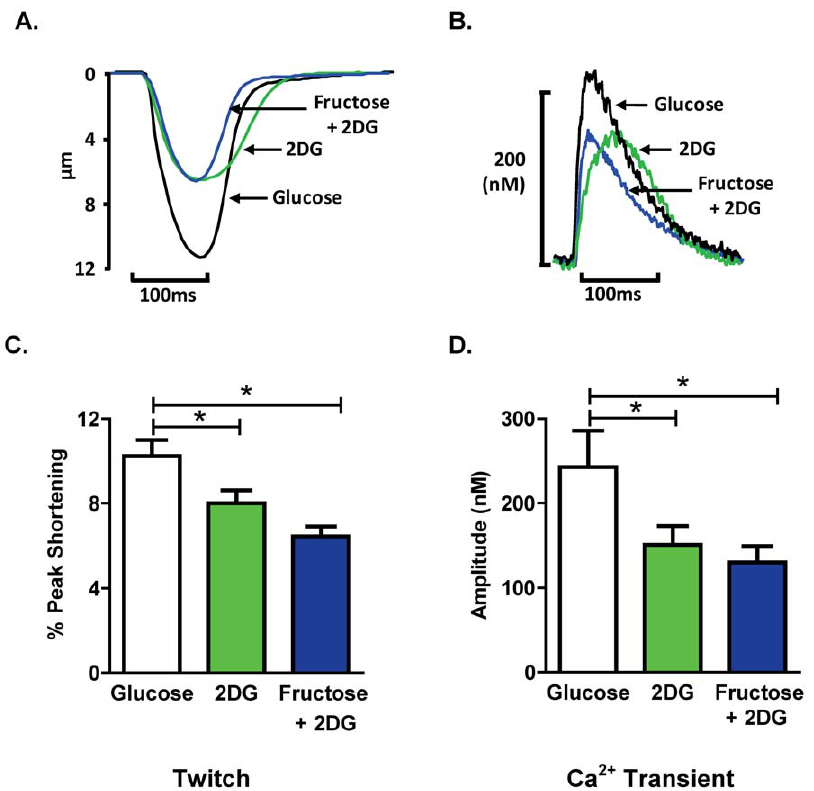
Figure 3. Effect of acute fructose on twitch and Ca 2 + transient profiles. A. Representative twitch profiles from cardiomyocytes superfused with glucose, 2 DG, or fructose + 2 DG solutions. B. Representative Ca 2 + transient profiles from cardiomyocytes superfused with glucose, 2 DG, or fructose + 2 DG solutions. C. Twitch peak shortening, normalized to diastolic cell length (% PS). D. Ca 2 + transient peak amplitude. Data presented as mean 6 s.e.m. n=10–28 cells/group. *p , 0.05 (1-way ANOVA, Newman-Keuls post-hoc test).